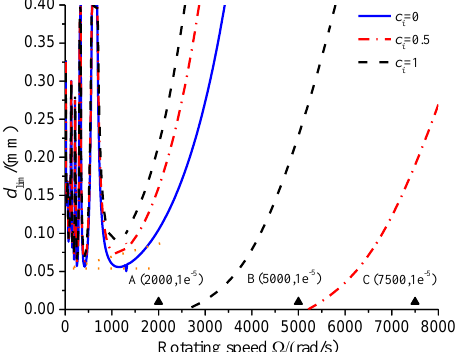
Figure 8. The variation of composite bar’s phase difference between successive undulations with the rotating speed.